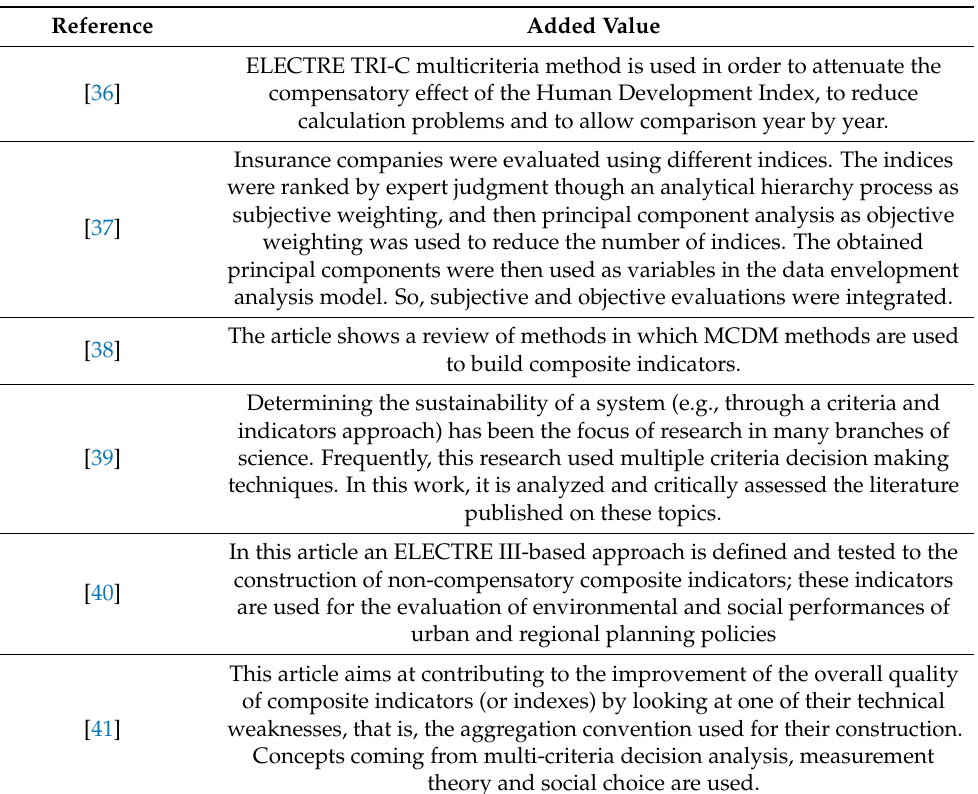
Table 1. Literature review on composite indicators based on